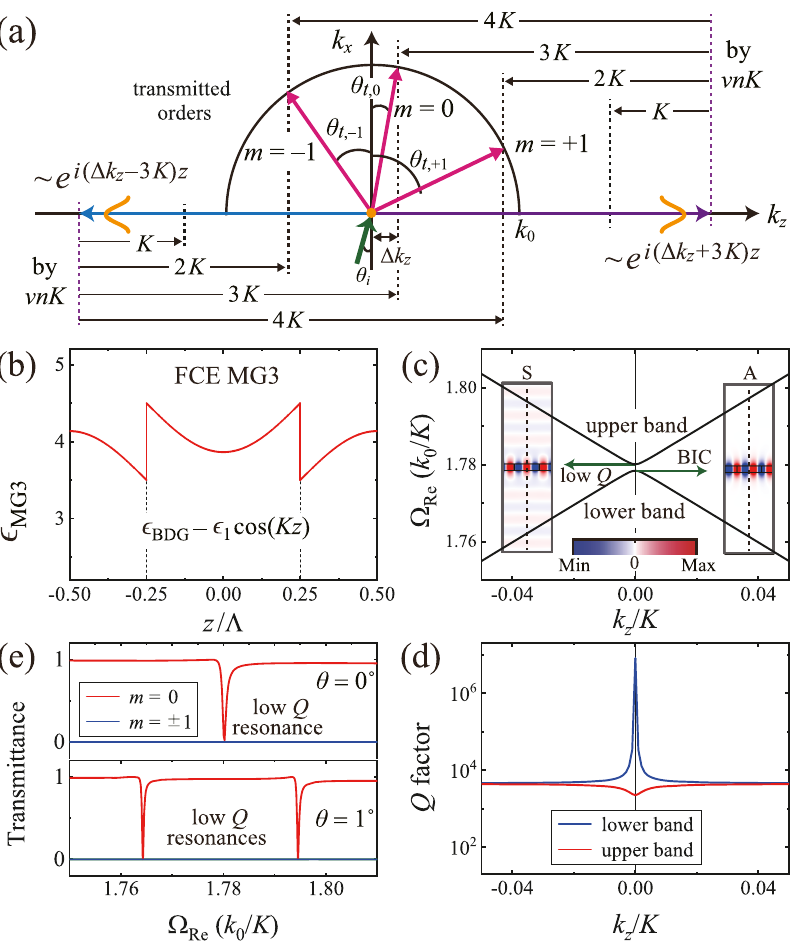
Figure 4: Resonant diffraction near the sixth stop band beyond the subwavelength limit. (a) Diffraction orders by Eq. (4) . (b) Spatial dielectric function with respect to z . Simulated (c) dispersion relations, (d) radiative Q factors, and (e) transmission spectra near the sixth stop band of FCE MS3. In the simulations, the following structural parameters were used: 𝜖